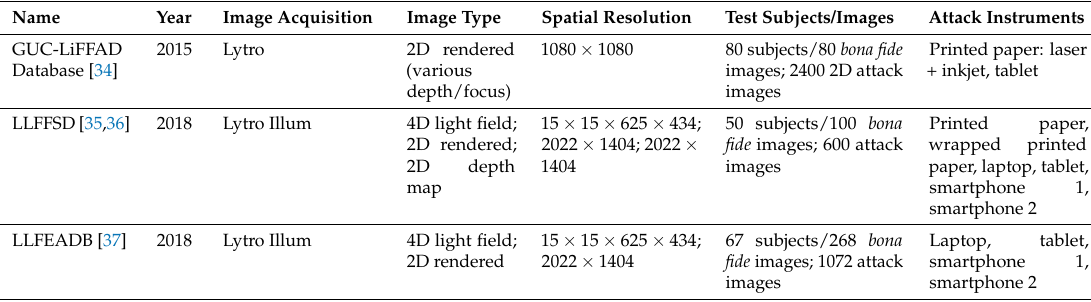
Table 3. Light-field face presentation attack detection